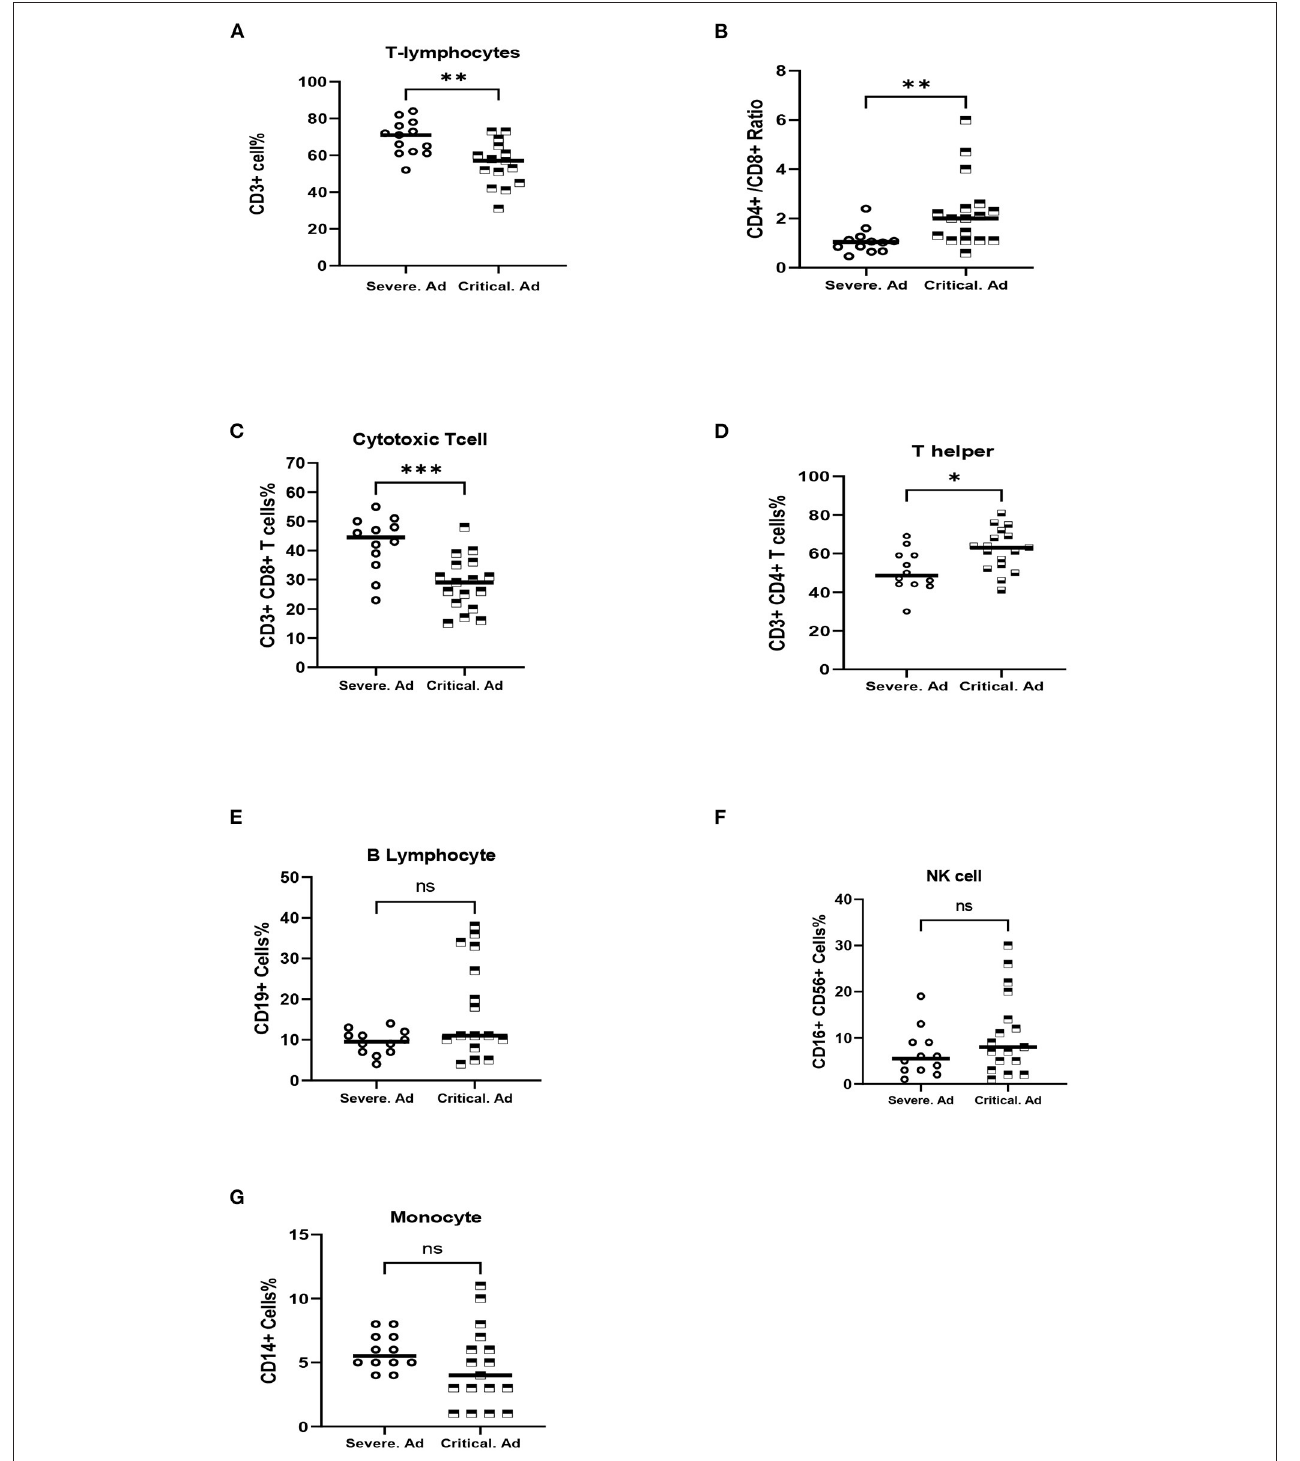
FIGURE 2 | Comparison of peripheral innate and adaptive immune cells of severe COVID-19 adult patients (Severe.Ad) with critical COVID-19 adult patients (Critical.Ad). (A) Total T-lymphocytes (CD3 + ). (B) CD4 + /CD8 + ratio, (C) Cytotoxic T cells (CD3 + , CD8 + ). (D) T helper (CD3 + , CD4 + ). (E) B lymphocytes (CD19 + ). (F) NK cells (C16 + , CD56 + ). (G) Monocyte (CD14 + ). * p < 0.05; ** p < 0.01; *** p < 0.001; NS, not significant.